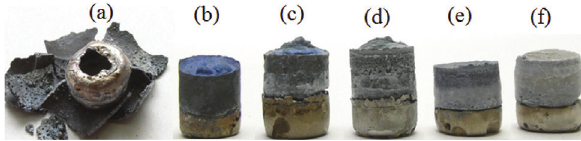
Fig. 7: View of the obtained metal and oxide phases for estimated composition of 5Al-20Co-75Ni mass% under a) 1 g-force, b) 30 g-force, c) 110 g-force, d) 350 g-force, e) 700 g-force, f) 1000 g-force